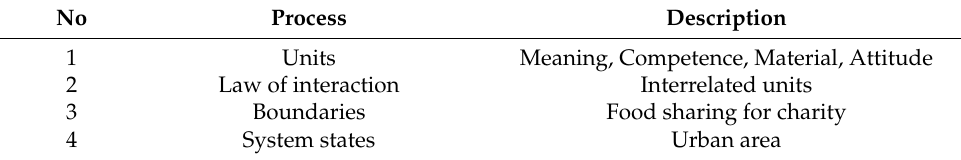
Table 5. Conceptual Development